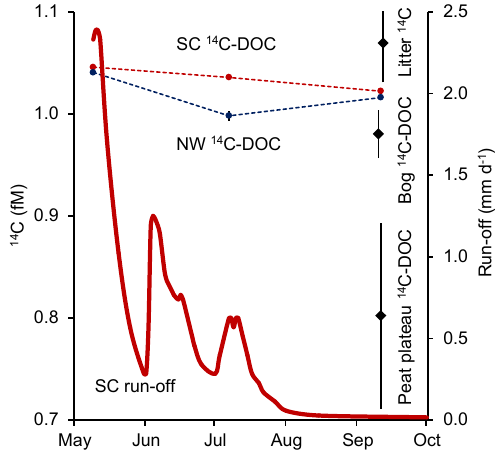
Figure 8. Radiocarbon characteristics of DOC at the Scotty Creek (SC) and Notawohka Creek (NW) outflows, of DOC in peat plateau (burned and unburned) and thermokarst bog pore water and of forest-floor litter. The Scotty Creek hydrograph for 2017 is shown. Error bars indicate 1SD among replicate samples. Error bars for stream DOC are all < 0 . 005 and thus hard to